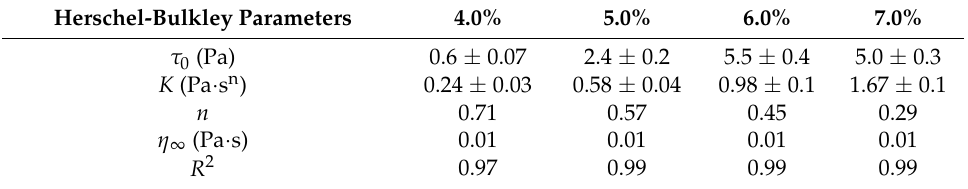
* n is the power law index.